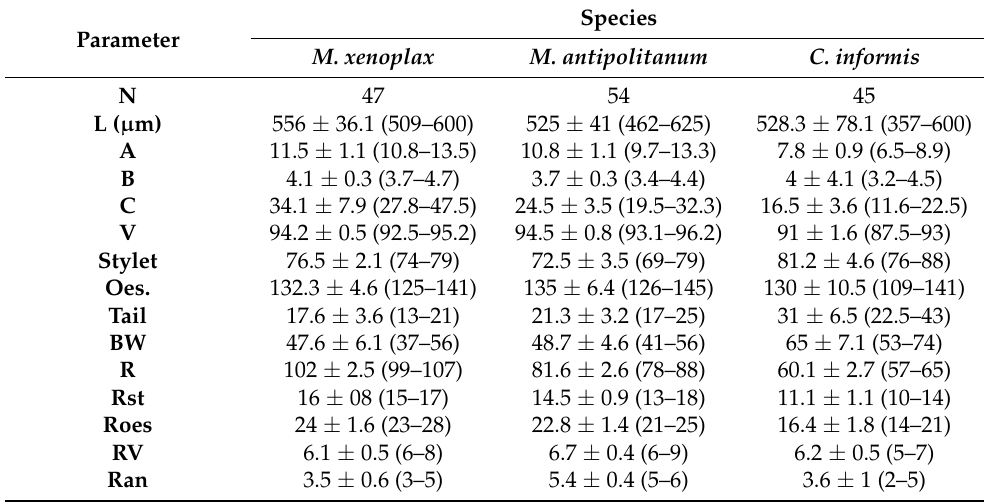
Table 1. Morphometric characteristics of M. xenoplax , M. antipolitanum , and C. informis used in this study. All measurements are in µ m given as mean ± SE (standard error), and range of minimum and maximum